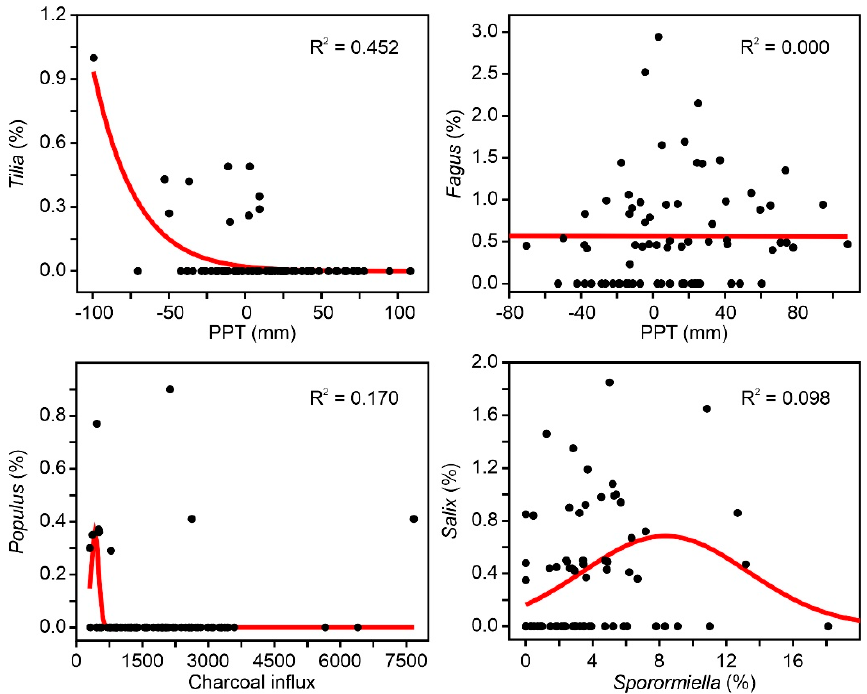
Figure 10. Examples of forest taxa with nonsignificant and/or misleading responses to external factors. Table 2. Linear (normal font) and exponential (italics) correlation coefficients between the forest taxa and the external drivers that were significant in the Gaussian response analysis (Figures 10 and 11). In most significant cases, the linear and exponential models showed very similar correlation coefficients, and the higher values were chosen. Correlations significant at p < 0.05 are in